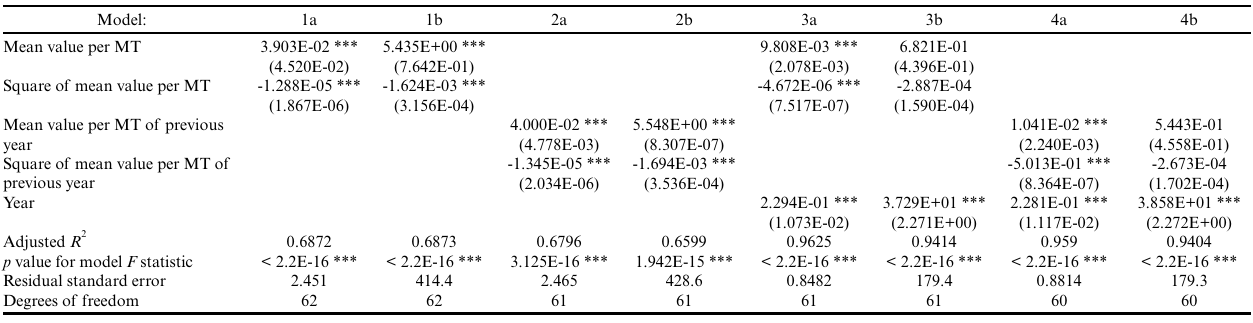
Table 2 . Summary of coefficients and overall model results. *** indicates significance less than or equal to 0.01. Standard errors are reported in parentheses below the value for each coefficient. Blank cells indicate where coefficients were not incorporated into a given model (MT: metric ton).